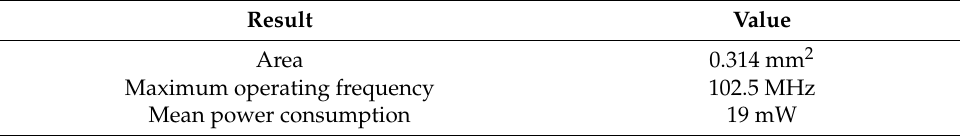
Table 7. Physical synthesis results for PAMPIUM